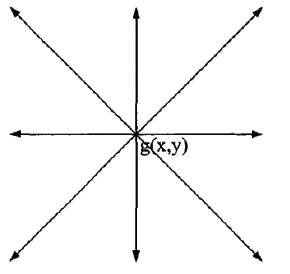
Figure 2. Fractional differential operation